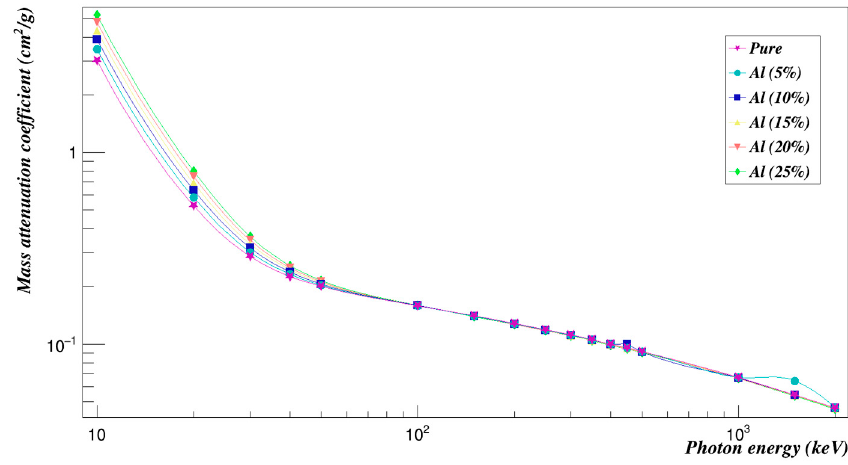
Figure 4. Photon mass attenuation coefficients of Polyimide doped with aluminum.